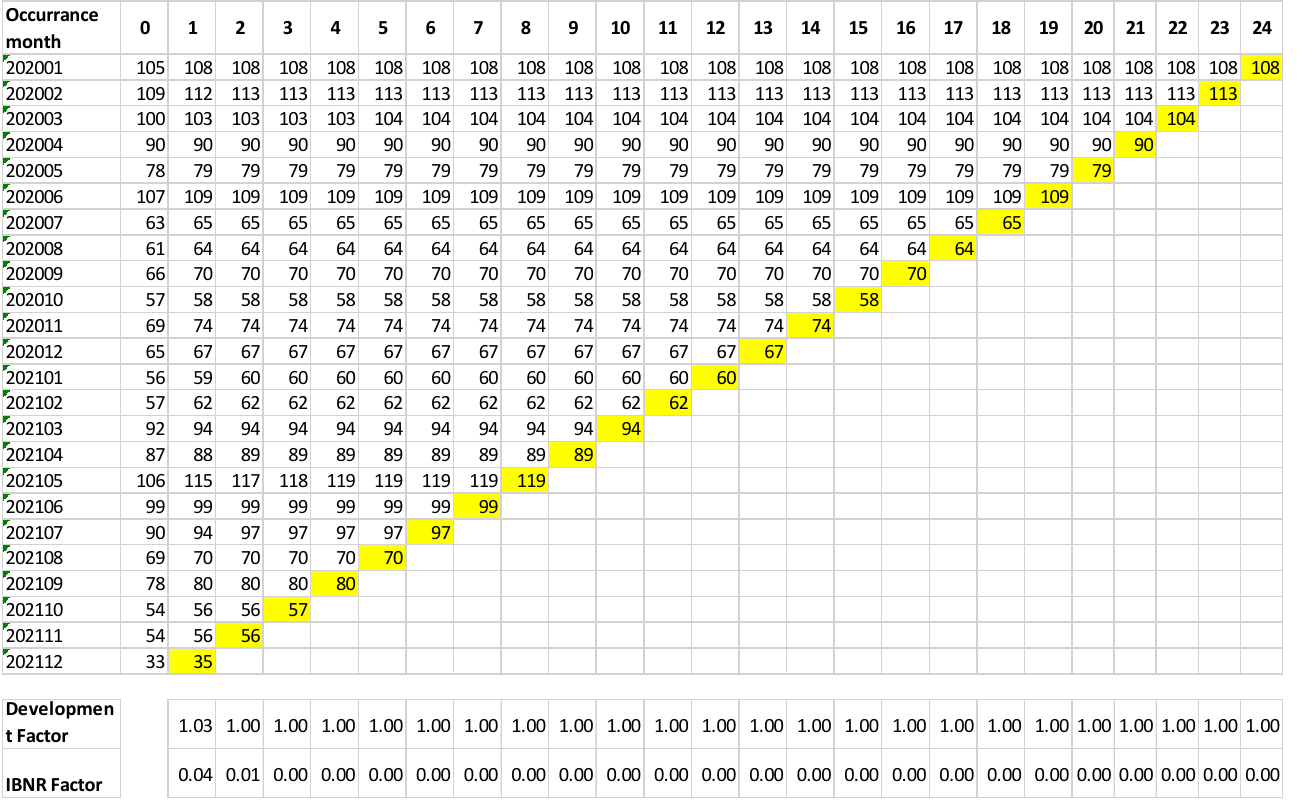
Figure 2. Incurred but not reported evaluation distributed by timing. Table 3. Temporal latency trend related to the occurrence of the event. Quarter Distribution